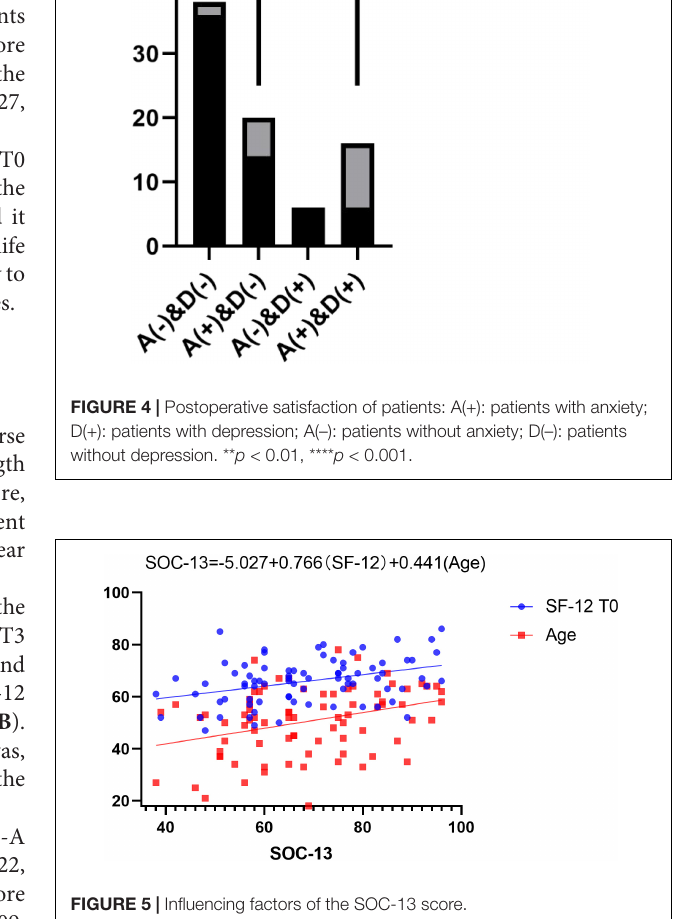
FIGURE 5 | Influencing factors of the SOC-13